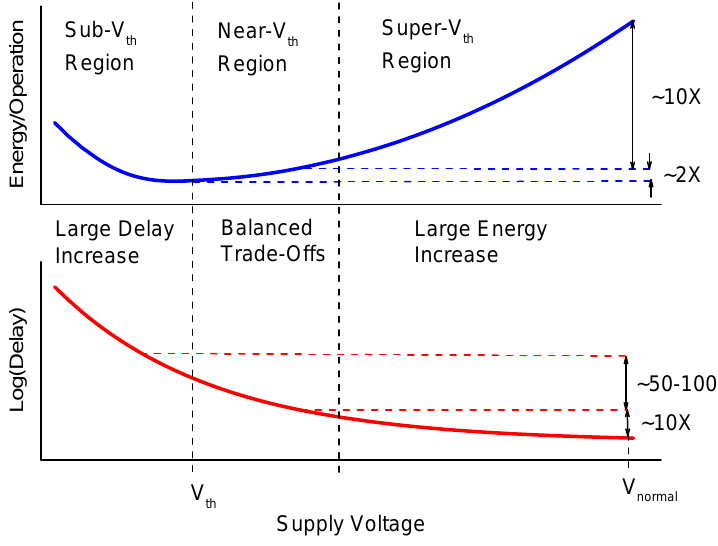
Figure 1. Energy and delay plots versus supply voltage scaling.